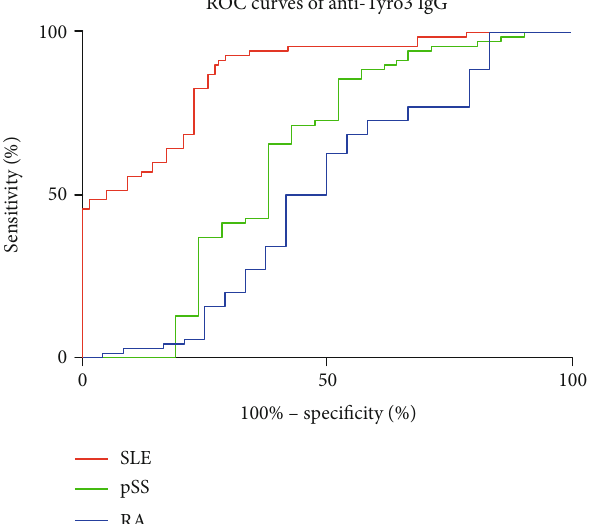
Figure 3: The receiver operating characteristic (ROC) curves of anti-Tyro3 IgG in SLE, RA, pSS, and HCs. The areas under the curve (AUC) of anti-Tyro3 IgG in SLE, RA, and pSS were 0.8708 (95% CI: 0.8136-0.9281) ( p < 0 : 0001 ), 0.5048 (95% CI: 0.3512-0.6583) ( p = 0 : 9447 ), and 0.6146 (95% CI: 0.4468-0.7824) ( p = 0 : 1125 ), respectively. SLE: systemic lupus erythematosus; RA: rheumatoid arthritis; pSS: primary Sjögren ’ s Syndrome.